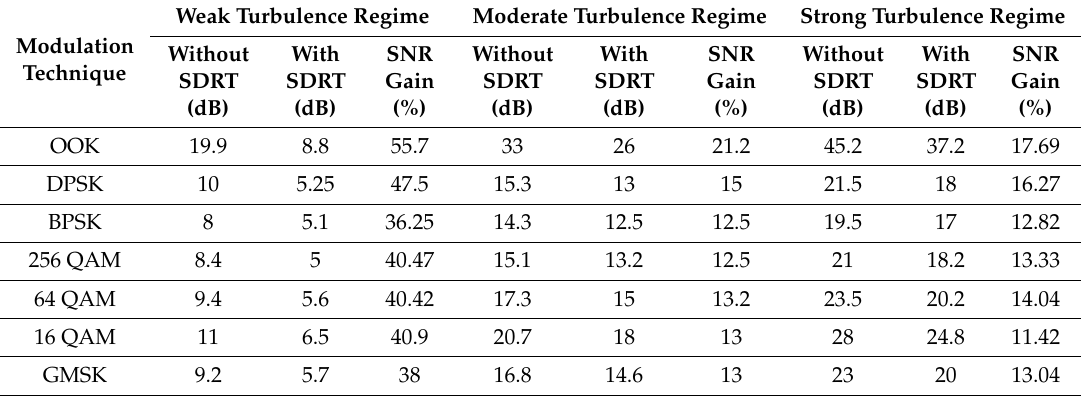
Figure 9. BER performance of different modulation formats with SDRT and without SDRT in a strong turbulence channel. Table 3. SNR values (in dB) for modulation techniques with SDRT and without SDRT at BER 10 − 8 for Weak, moderate and strong regimes.